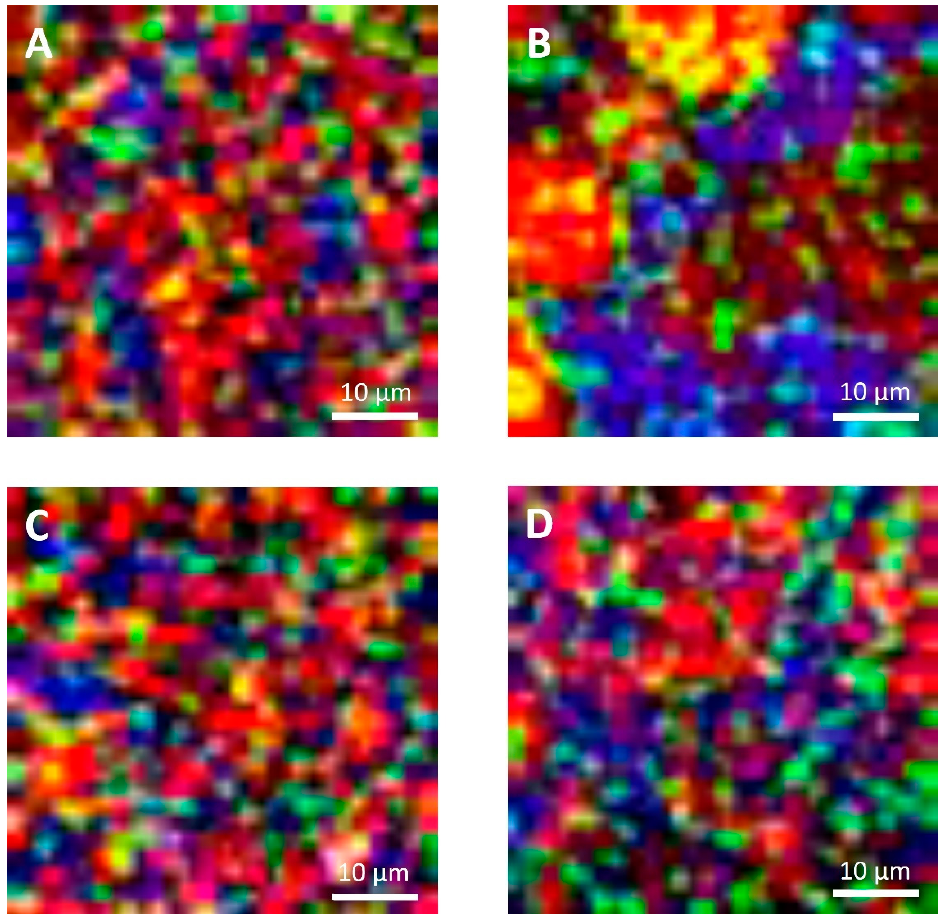
Figure 4. Confocal Raman micrographs of cream cheeses. Cream cheese A before freezing ( A ), after freezing ( B ). Cream cheese B before freezing ( C ), after freezing ( D ). Red: fat. Green: protein. Blue: water.